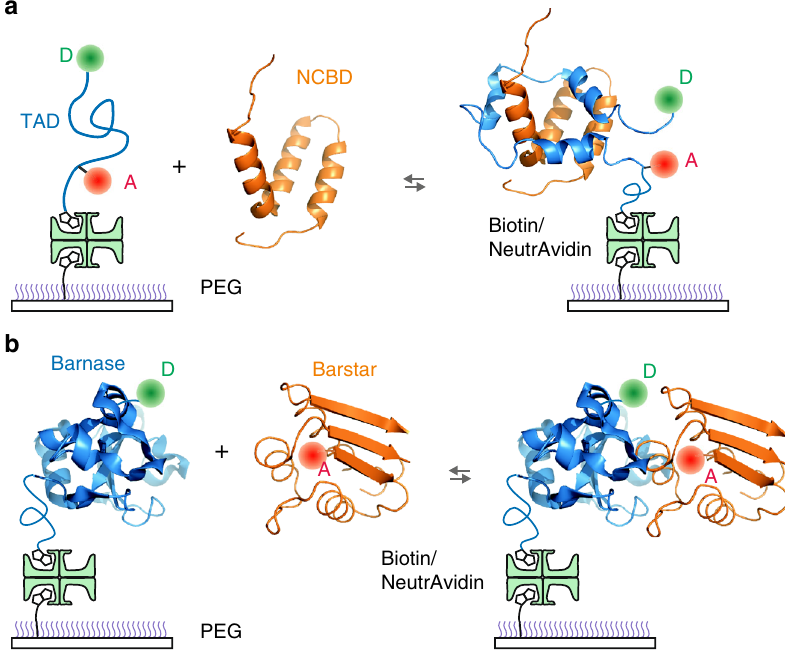
Fig. 1 Binding experiment of immobilized proteins. a Alexa 488 (D, donor) and Alexa 647 (A, acceptor) are attached to cysteine at the C-terminus and 4- acetylphenylalanine at the N-terminus of TAD, respectively. Dye-labeled molecules were immobilized on a polyethylene glycol (PEG)-coated glass surface via a biotin – NeutrAvidin linkage and incubated with unlabeled NCBD in solution. b Donor-labeled barnase was immobilized on a glass surface and incubated with acceptor-labeled